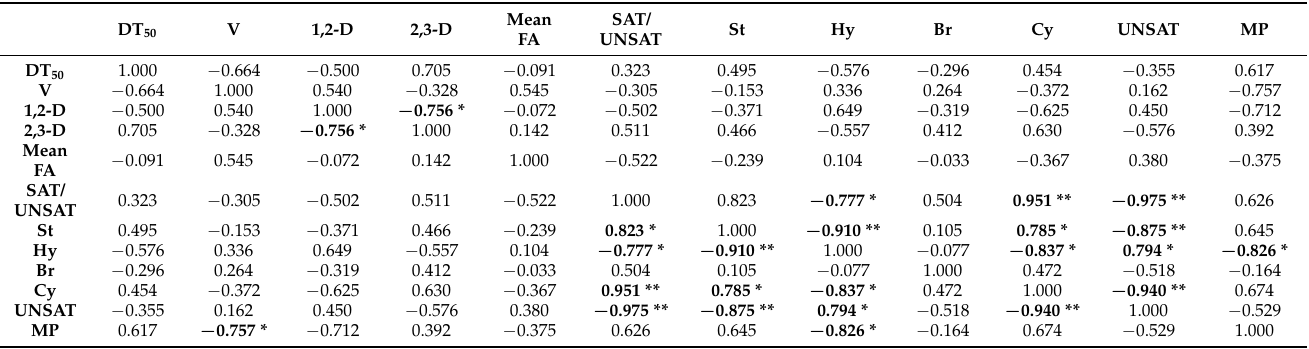
Table 6. Pearson’s correlation matrix for phenol degradation kinetic parameters, catechol 2,3- dioxygenase activity, membrane permeability, and FAME indexes for P. moorei KB4 under suboptimal growth